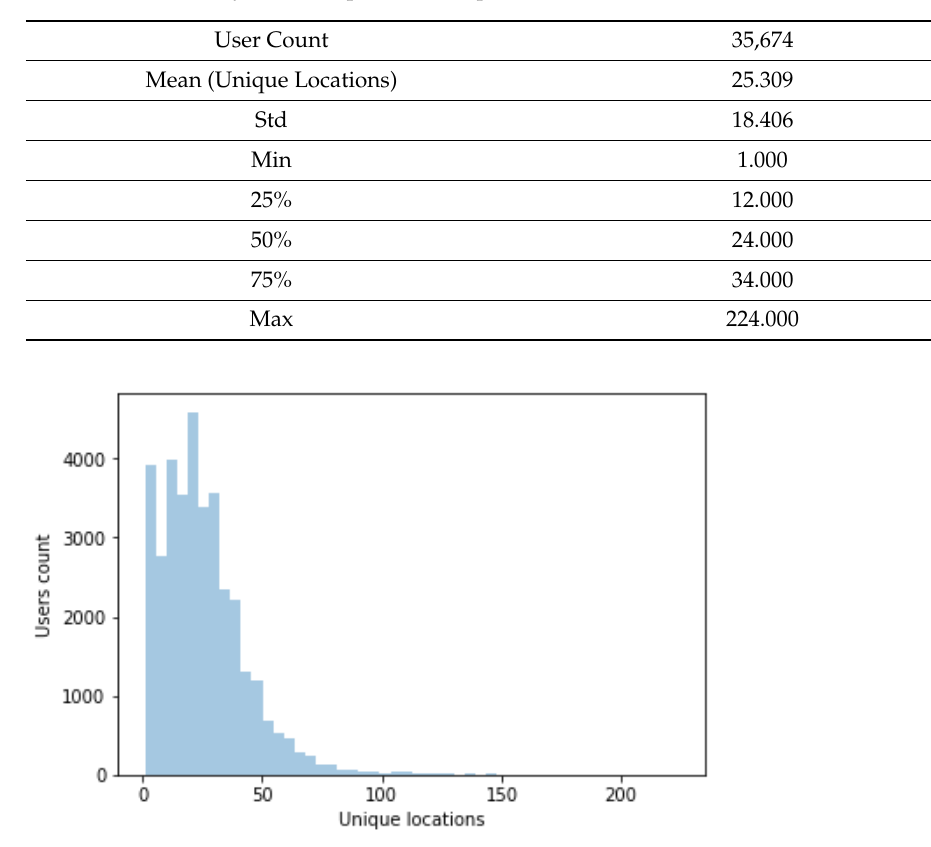
Table 2. Dataset analysis on unique locations per user.